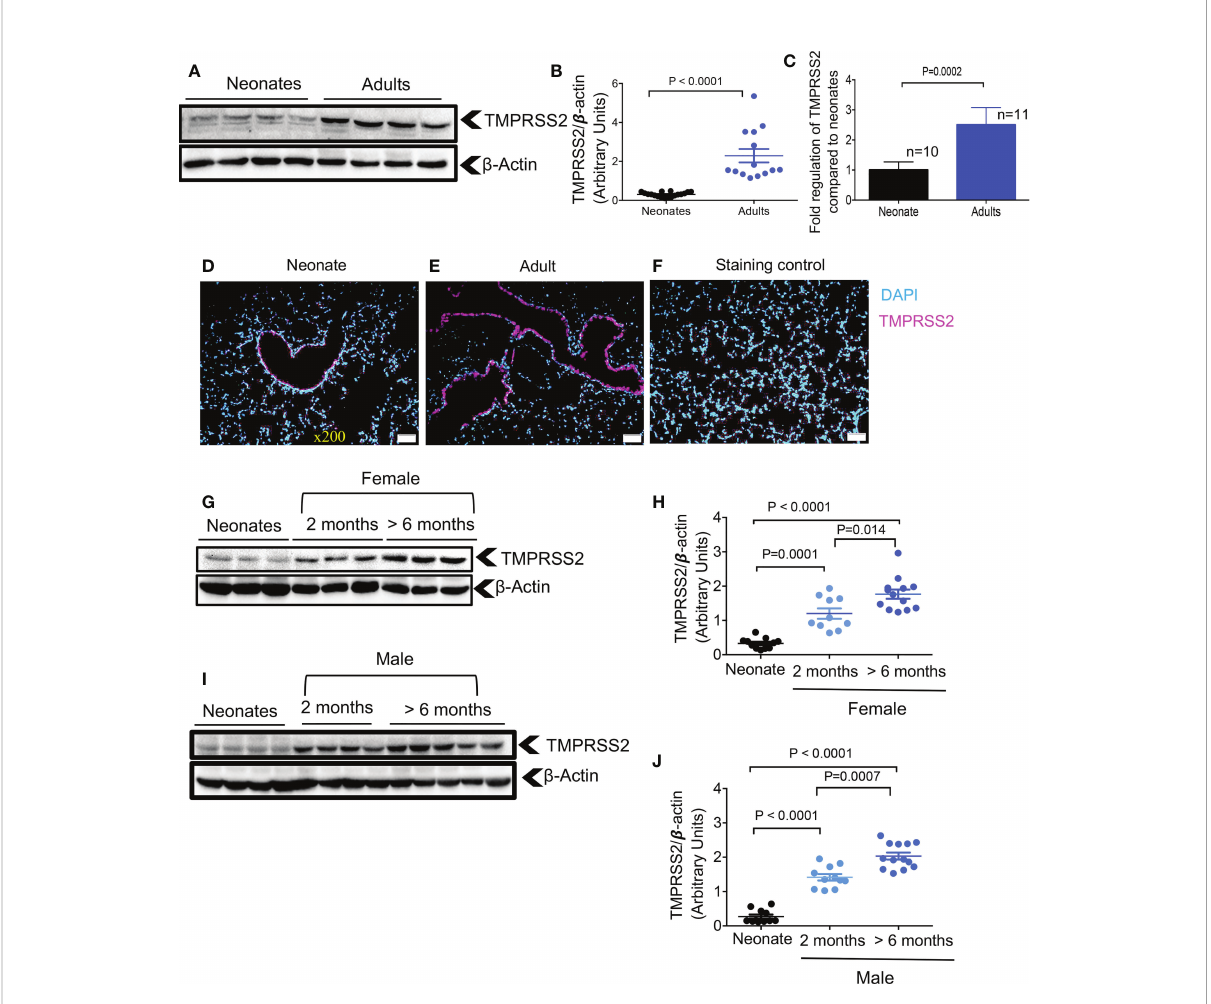
FIGURE 2 Developmental regulation of TMPRSS2 in the lung tissues of mice. (A) Representative western immunoblots, and (B) cumulative data of TMPRSS2 protein in the lung tissues of neonatal versus adult mice (> 6 months). (C) Cumulative data showing fold regulation of TMPRSS2 mRNA in the lung tissues of neonatal versus adult mice (> 6 months). (D) Representative immuno fl uorescence (IF) images of TMPRSS2 expression in the lung tissue of a neonatal mouse, and (E) an adult mouse (5 sections/tissue, n= >3/group). (F) IF image of the lung section stained with the secondary antibody as control. Scale bar: 100 m m. Magni fi cation x200. (G) Representative western immunoblots, and (H) cumulative data of TMPRSS2 protein in the lung tissues of neonatal (8 days old), young adults (2 months) versus older adult (> 6 months) female mice. (I) Representative western immunoblots, and (J) cumulative data of TMPRSS2 protein in the lung tissues of neonatal, young adults (2 months) versus older adult (> 6 months) male mice. All blots were repeated for reproducibility and lanes were loaded with equal amounts of protein. Quanti fi cation of ACE2 and TMPRSS2 normalised to the loading control. Error bars indicate mean ± SEM from at least three independent